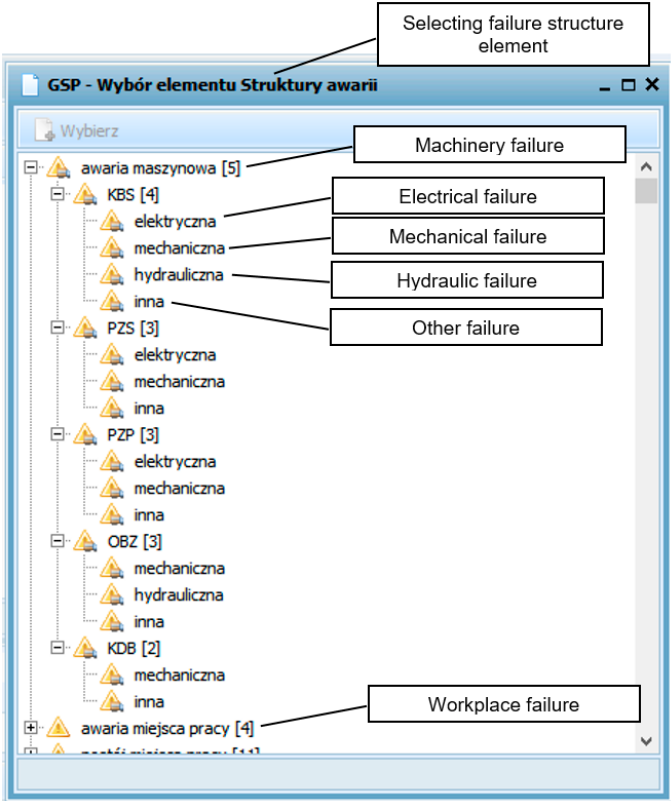
Figure 2. View of the script for selecting failure structure elements (unscheduled downtime).